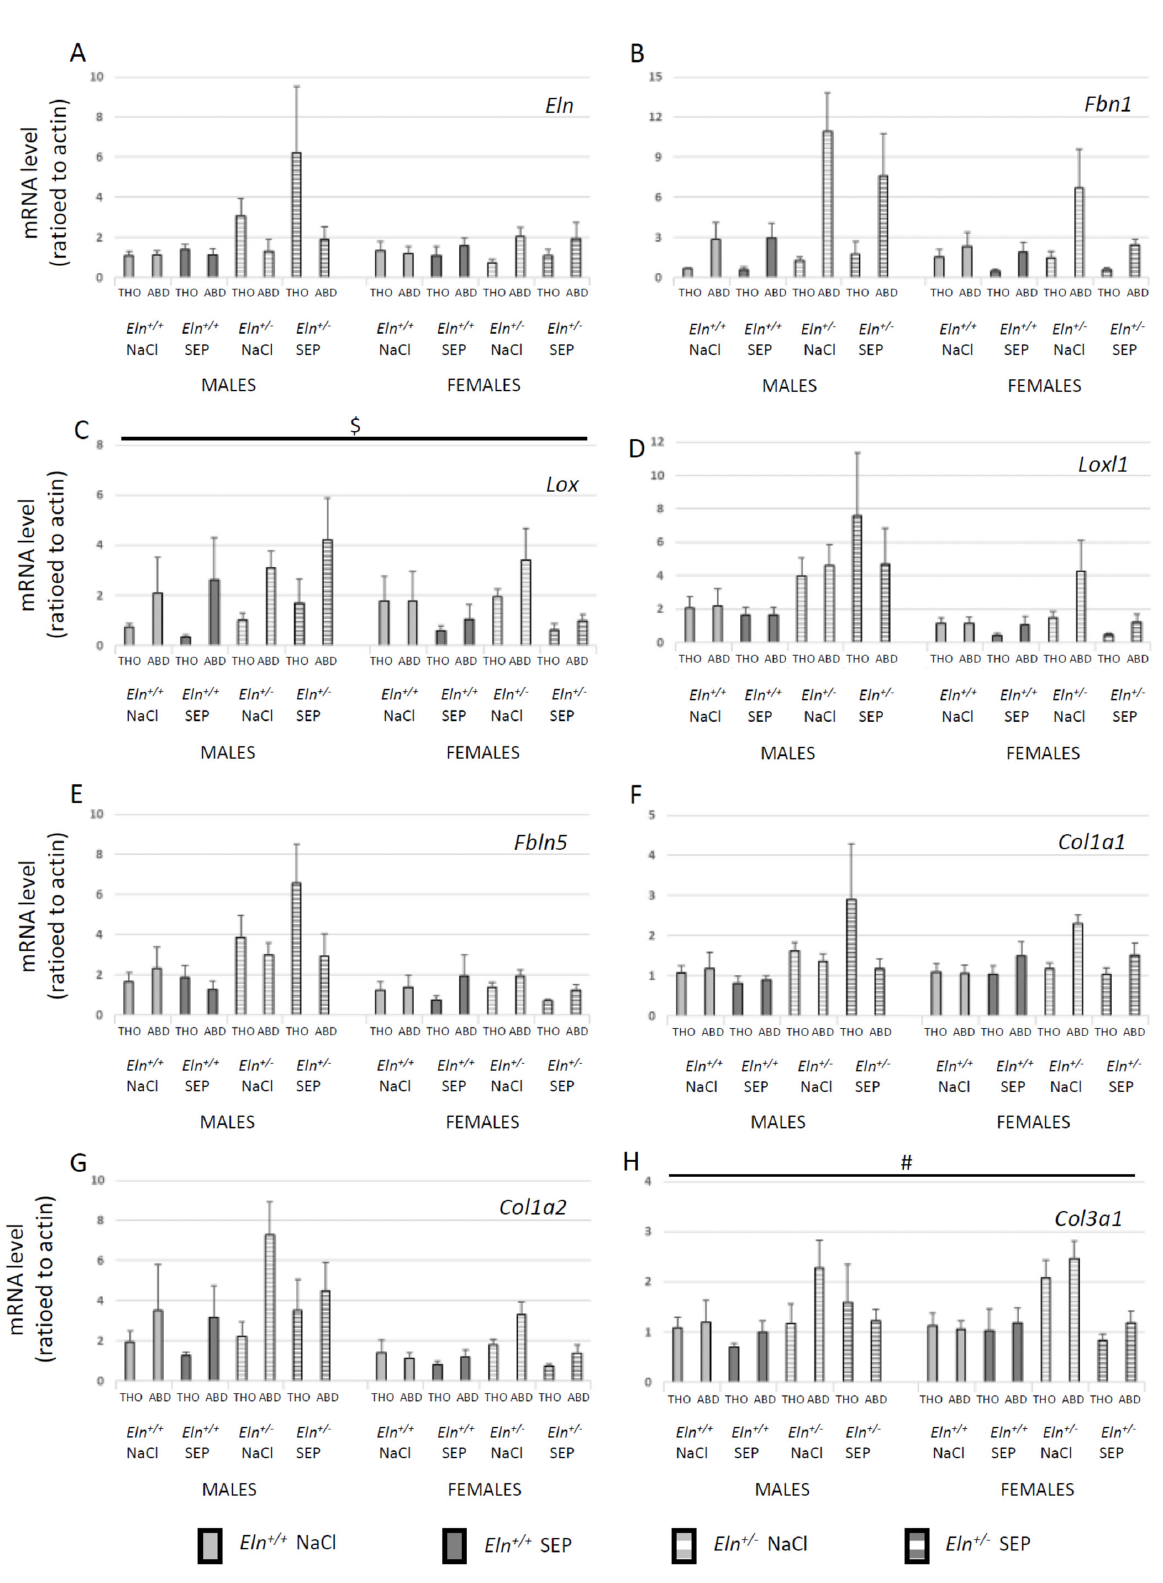
Figure 9. Effect of SEP treatment on the levels of mRNAs transcribed from the genes of the major components of aortic elastic and collagen fibers. The measurements were performed by RT-qPCR in thoracic (THO) and abdominal (ABD) aorta segments 3 days after SEP or NaCl (control) intravenous injection in the caudal vein of male and female mice of Eln +/+ or Eln +/- genotype. ( A ) tropoelastin ( Eln ), ( B ) fibrillin-1 ( Fbn1 ), ( C ) lysyl oxidase ( Lox ), ( D ) lysyl oxidase-like-1 ( Loxl1 ), ( E ) fibulin-5 ( Fbln5 ), ( F ) type I collagen alpha-1 ( Col1a1 ), ( G ) type I collagen alpha-2 ( Col1a2 ), ( H ) type III collagen